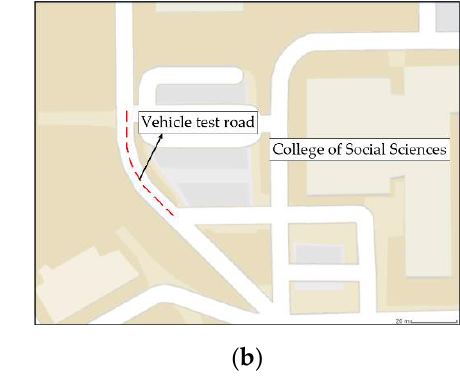
Figure 16. Vehicle test roads: ( a ) straight road, ( b ) curved road. Table 4. Minimum radius of curvature for curved roads according to the design standards. Velocity (km/h)